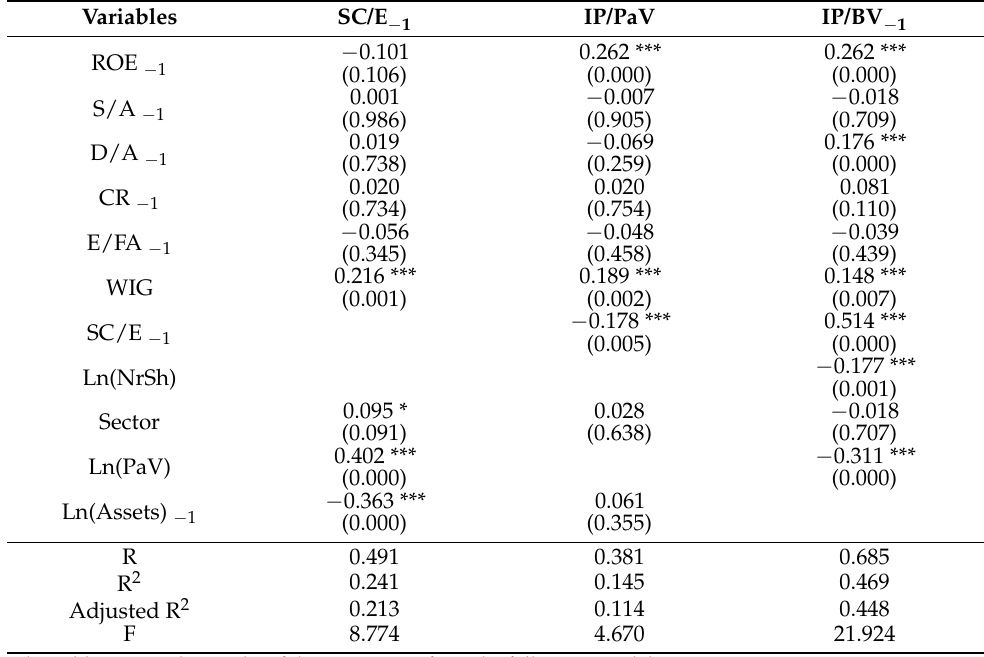
Table 9. Regression analysis of the determinants of second-degree financing